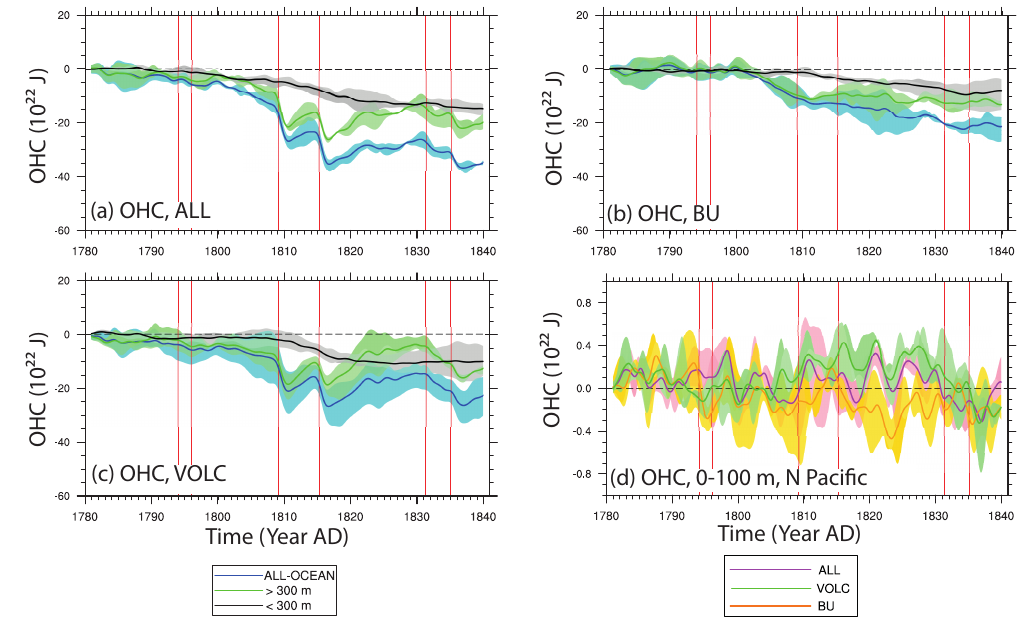
Fig. 5. Ensemble mean of detrended global ocean heat content (OHC) anomalies relative to CTRL1780, plotting technique analog to Stenchikov et al. (2009). For (a) – (c) the black curve shows global total OHC (0–6020m), the green curve global OHC of the top 300m, the blue curve global OHC of the layers below 300m (300–6020m). (a) For ALL; (b) BU; (c) VOLC. (d) Ensemble mean of local OHC anomalies relative to CTRL1780 for the layers between 0 and 100m in depth for the northern Pacific, Bering Sea region. Envelope shows the min/max values. Red vertical lines highlight the years in which a volcanic eruption